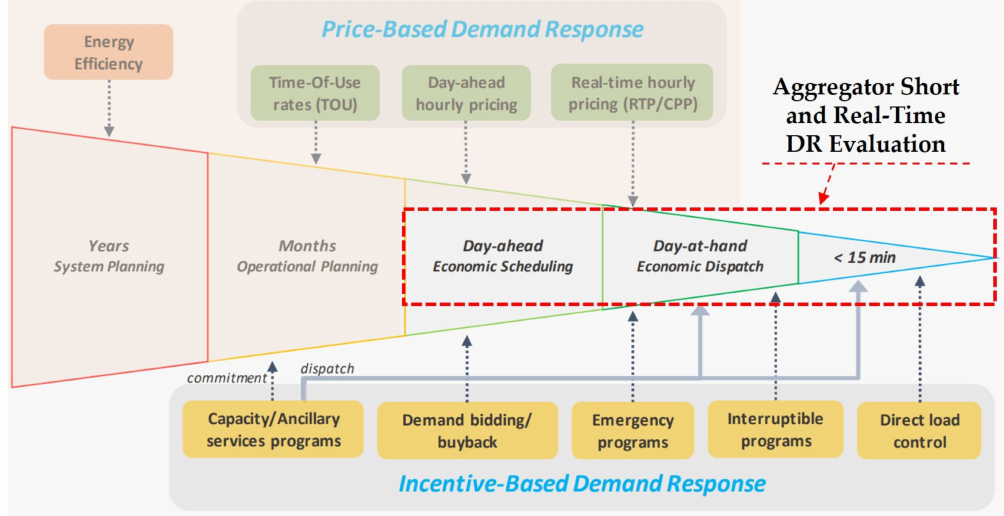
Figure 4. The timescale of demand response implementation. Adapted from